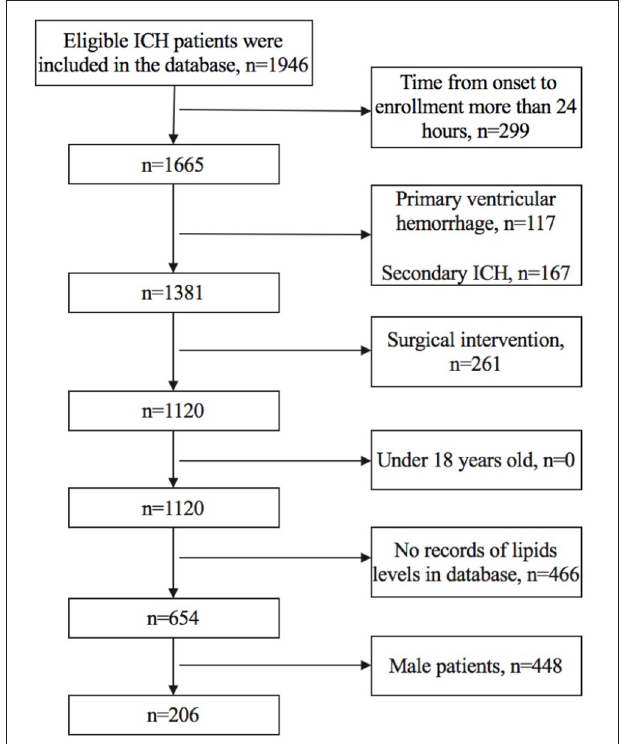
FIGURE 1 | Flowchart of patients’